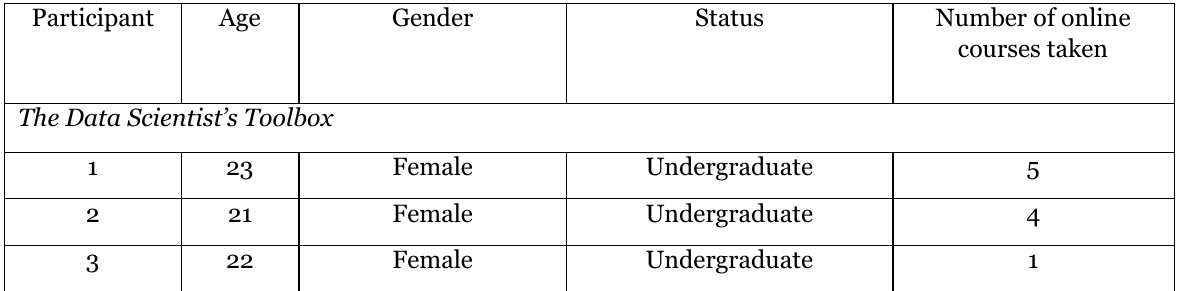
Demographic Information on Participants